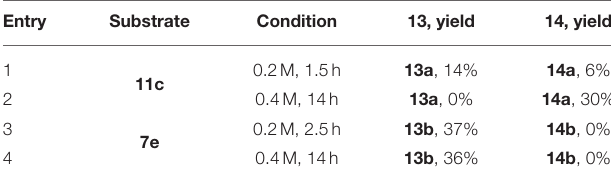
TABLE 2 | Effect of reaction conditions on the reduction of 11c and 7e